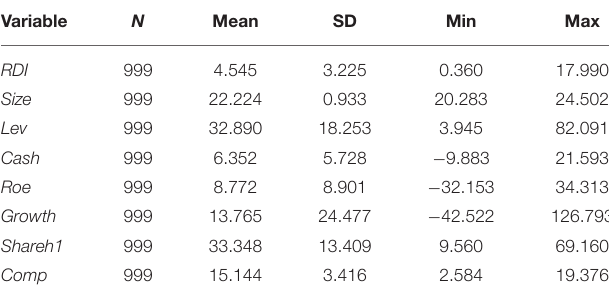
TABLE 2 | Descriptive statistics results.